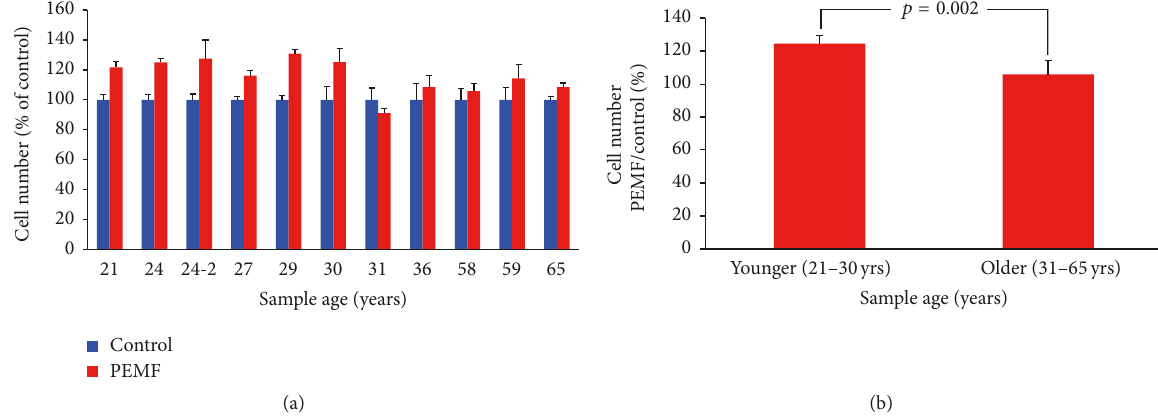
Figure 1: Effect of PEMF on hBMSC preosteoblastic cell number. (a) Human preosteoblasts derived from bone marrow stromal cells of 21–36-year-old women were treated with PEMF for 10 days; cells from 58-, 59-, and 65-year-old women were treated with PEMF for 20 days. Cell number/well was calculated using a hemocytometer ( 𝑛 = 3 –6 wells). (b) Aggregation of the data into the two age groups, 𝑛 = 5 -6. The statistical 𝑝 value for the younger versus older samples is shown using Student’s 𝑡 -test